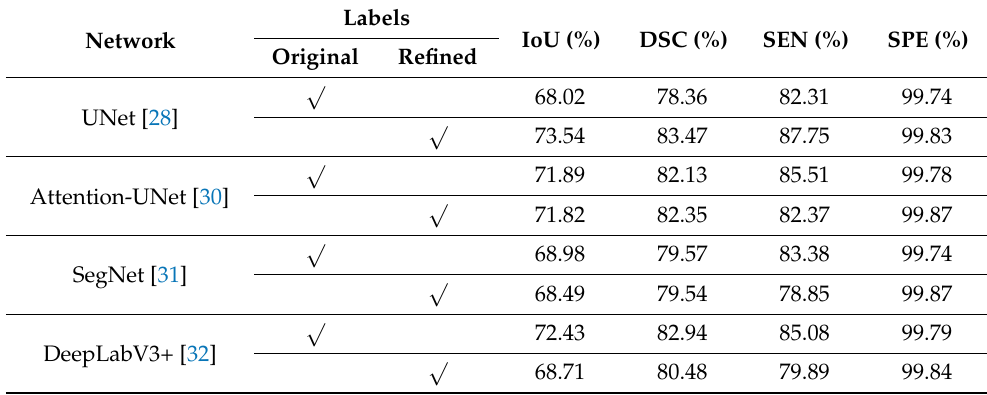
Table 2. Comparison of lesion segmentation performance using original labels and refined hierarchi- cal labels.